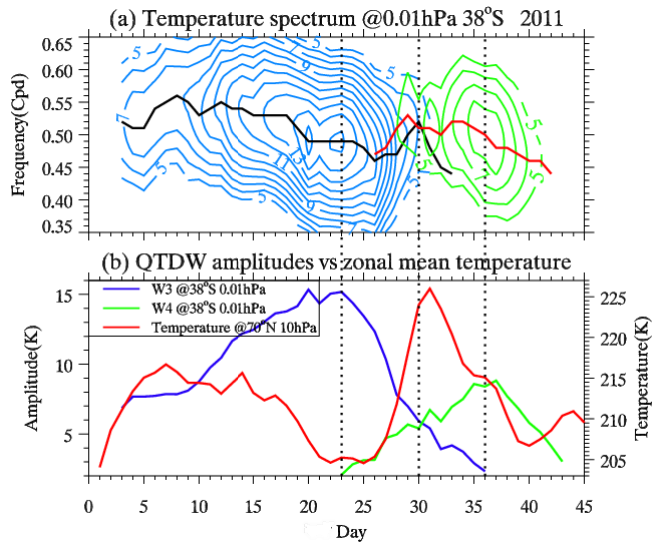
Figure 3. ( a ) Temporal variations of the temperature spectrum for oscillations at s = 3 (blue curves) and s = 4 (green curves) at 0.01 hPa and 38° S. The black and red lines in ( a ) indicate the maximum amplitudes. The maximum amplitudes are shown in ( b ) with blue and green lines for W3 and W4, respectively. The red line in ( b ) is the zonal mean temperature at 10 hPa and 70° N, used to indicate the Sudden Stratospheric Warming. The vertical dot lines are the same as in Figure 2. During January and February 2012, only a strong W3 was observed, as shown by Figure 4. The baroclinically unstable regions occurred mainly at middle and high lati- tudes of the summer hemisphere, as shown by Liu et al. [20] and Yue et al. [9]. It was proposed that wave excitation occurs through wave – mean flow interaction if the critical layer (where the background wind equals the wave phase speed) cuts into an unstable area [2,8,21]. In this case, a relatively strong summer easterly jet provides favorable con- ditions for the propagation and amplification of W4, and thus promotes the accom- plishment of wave number transitions, which can be further expounded by examining the different atmospheric conditions during these two years.